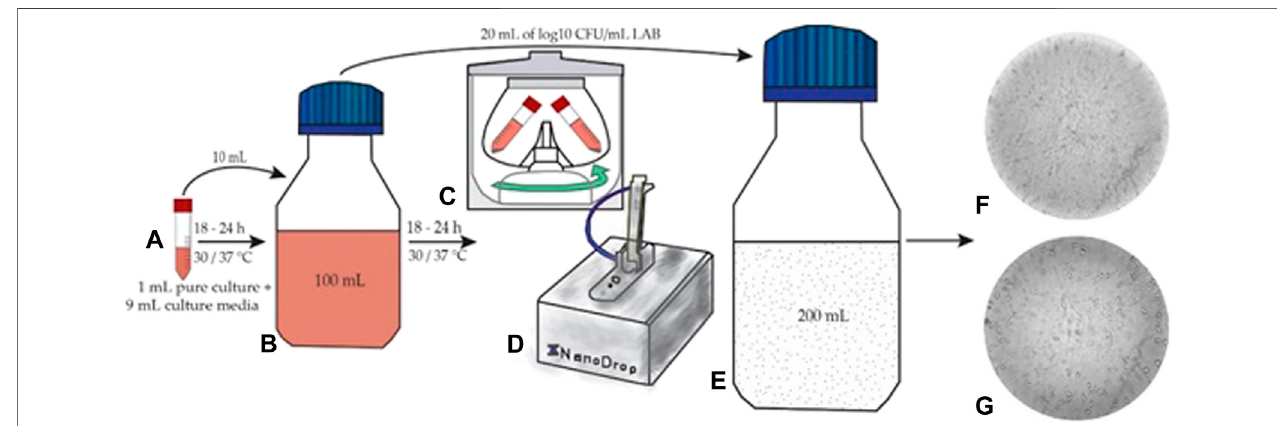
FIGURE 1 | Fermentation process (A) microorganism activation (B) re-incubation (C) washing step (D) dough fermentation (E) viability of LAB in Petri plates (F,G) LAB under the microscope.